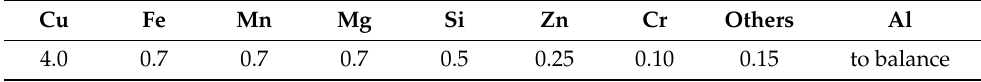
Table 1. Chemical composition of EN AW-2017A aluminum alloy (% weight).